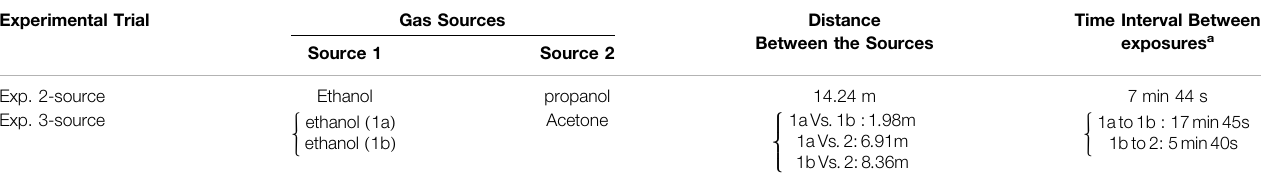
TABLE 1 | Summary of the set-ups of the fi eld experiments for the ELBA algorithm evaluation. Experimental Trial Gas